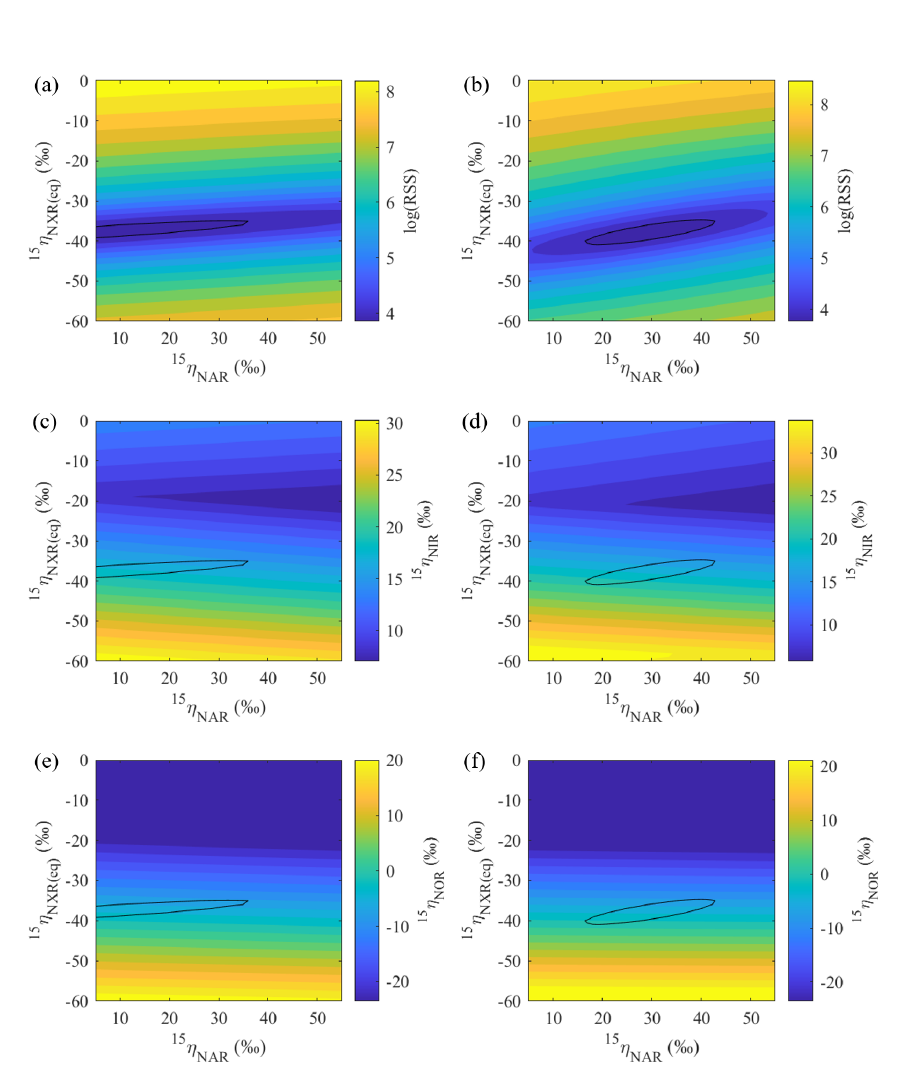
re-oxidation rate constants under the no-exchange 2